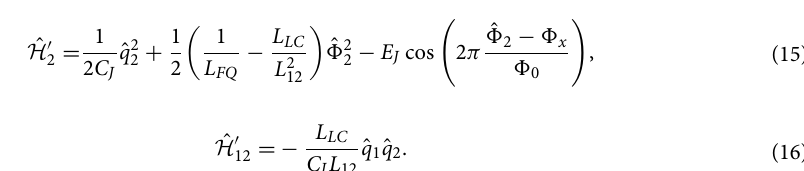
Figure 6. Numerically calculated matrix elements for i h k l where , , , and respectively represent the second, third, fourth, and fifth excited states of ˆ H 2 . | � | � | � Numerically calculated matrix elements for i (cid:31) (cid:31) x axis ranges are smaller than those in Fig.